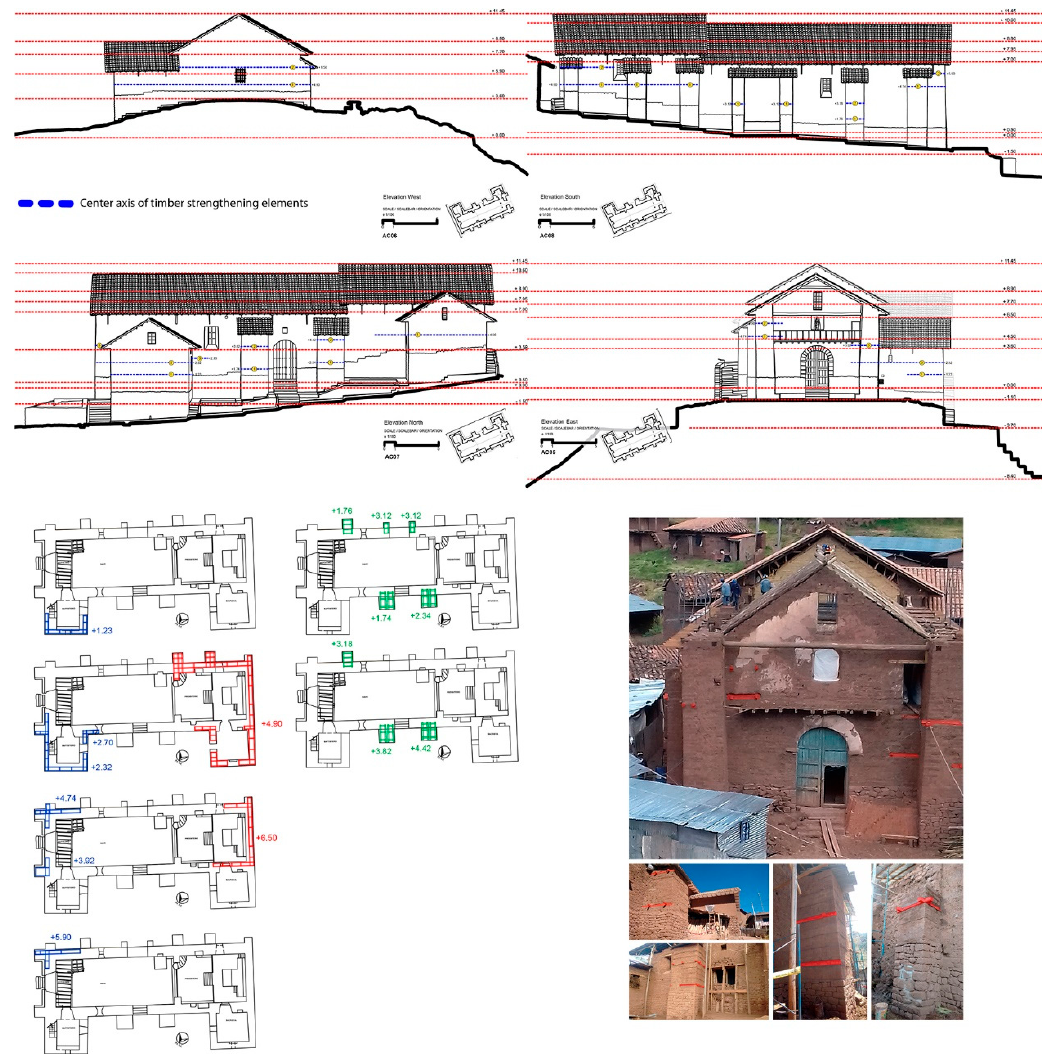
Figure 4. Configuration of timber-embedded corner keys and horizontal buttress timber keys in elevation. Several views are shown during the retrofitting work, with the timber-embedded elements highlighted in red.